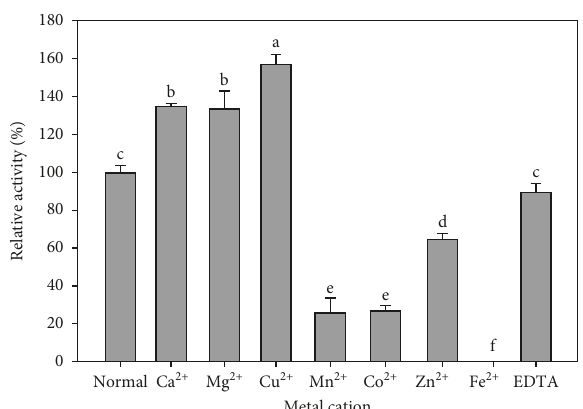
Figure 3: Effect of metal ions on Bt α GTase enzyme activity. The purified enzyme was preincubated with various metal ions for 10min, and the enzyme activity was subsequently measured under standard conditions using G2 and amylose as